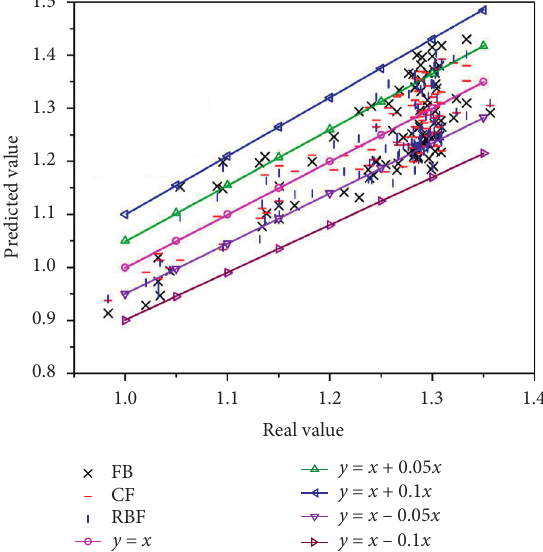
Figure 7: Comparison of prediction errors of S